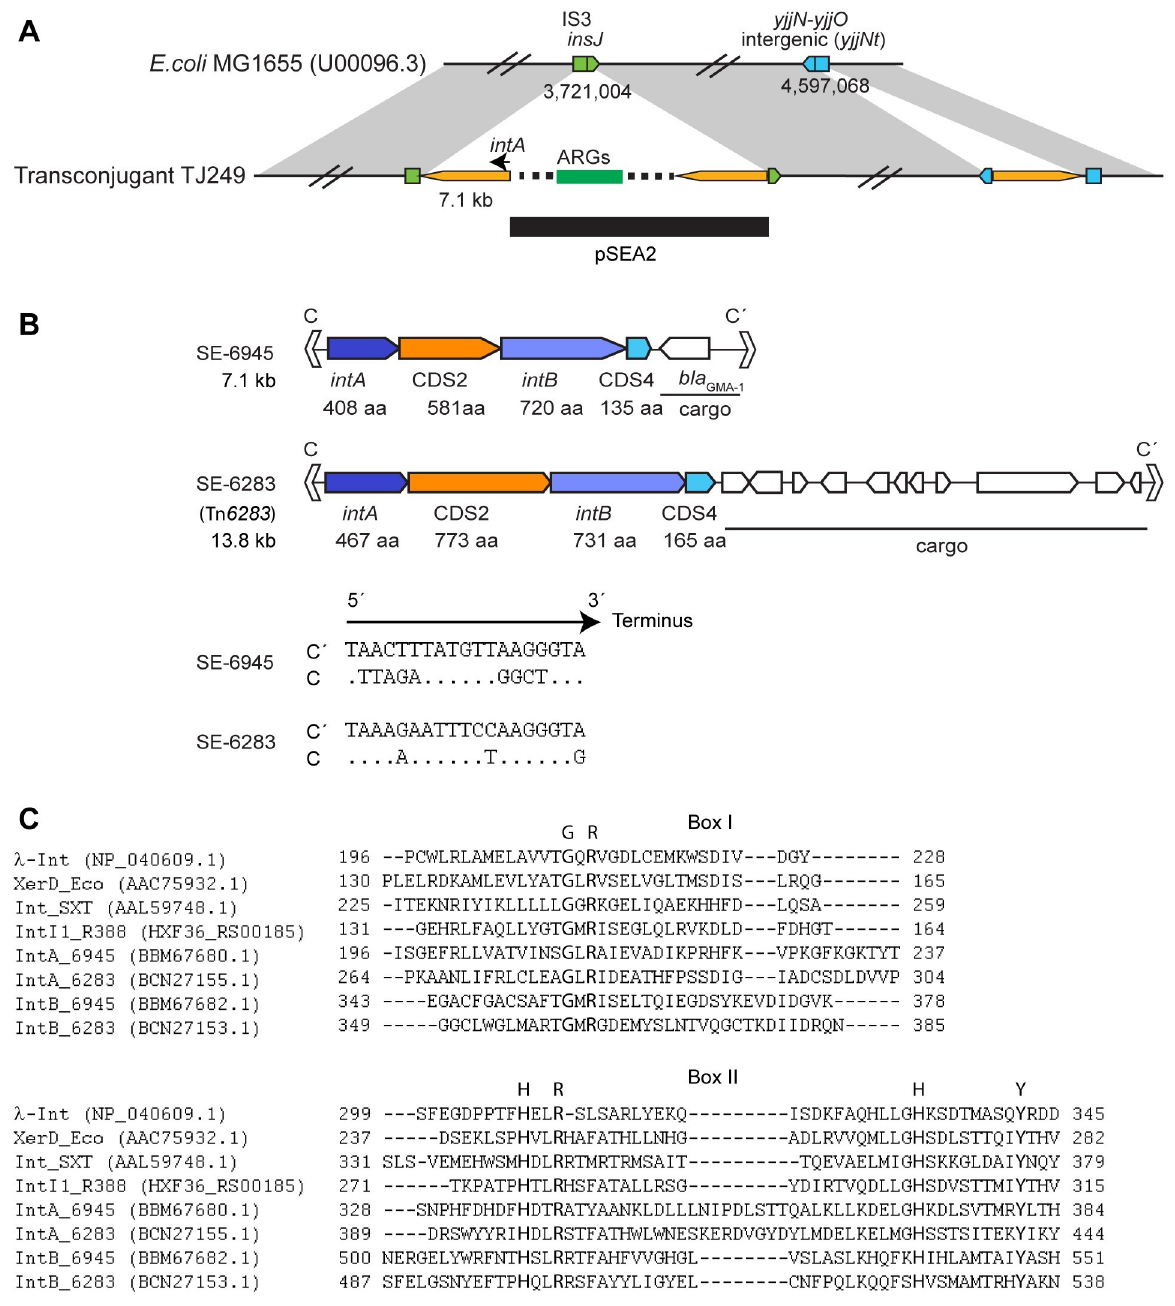
Fig 1. Genetic features of SEs. (A) Schematic representation of the 7.1 kb element and pSEA2 insertion locations in E . coli TJ249. Yellow pentagons are the 7.1 kb element. The sequence from pSEA2 is indicated by a horizontal line. (B) Upper panel: Genetic organization of SE-6283 and SE-6945. Lower panel: Nucleotide sequences of imperfect inverted repeat motifs C and C’. Dots indicate that bases in C are identical to those in C’. (C) Presence of R-H-R-Y motif in IntA and IntB. IntA and IntB sequences are aligned with sequences of known tyrosine recombinases based on secondary structure prediction using PROMAL 3D [34]. The aligned regions corresponding to box I and box II in [35] are shown.